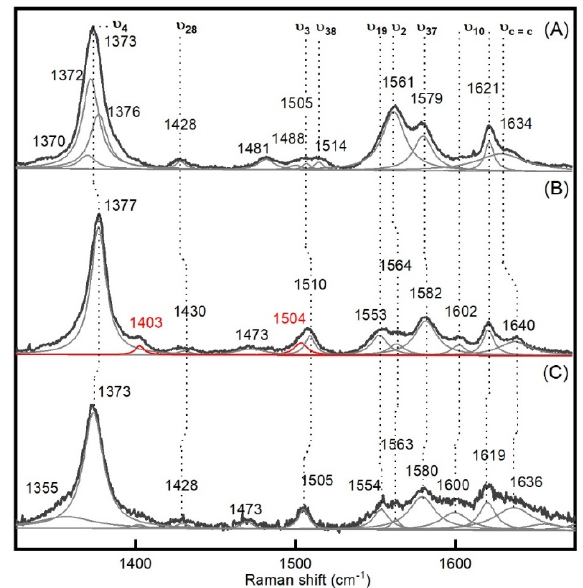
Figure 2. RR spectra of BsDyP recorded with Soret band excitation at pH 7.6 and 298 k under aerobic conditions. ( A ) Resting enzyme, measured at open circuit potential. ( B ) Compound II, measured at − 0.190 V applied potential. ( C ) Compound I, obtained after addition of ferrocyanide to the product of aerobic electrolysis at − 0.190 V shown in panel ( B ). Black lines are experimental spectra. Gray lines are the result of spectral deconvolution and correspond to Lorentzian RR bands of the heme. Bands and labels in red are assigned to tyrosyl radical